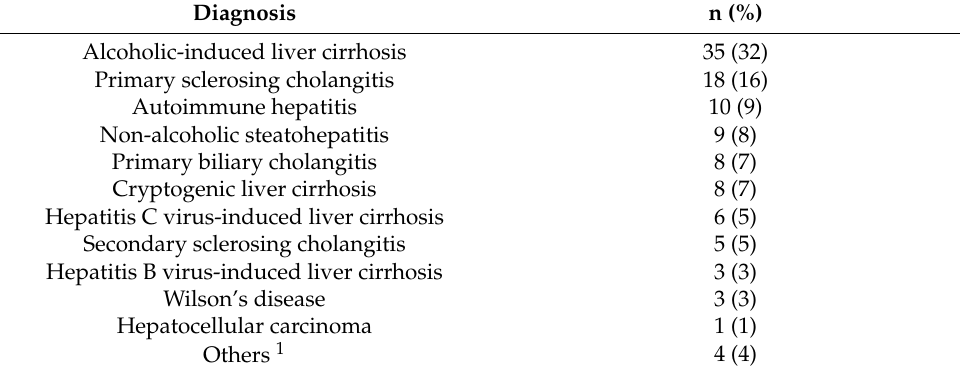
Table 2. Etiology of liver cirrhosis is shown as absolute number, n, and percentage. Diagnosis n (%) Alcoholic-induced liver cirrhosis 35